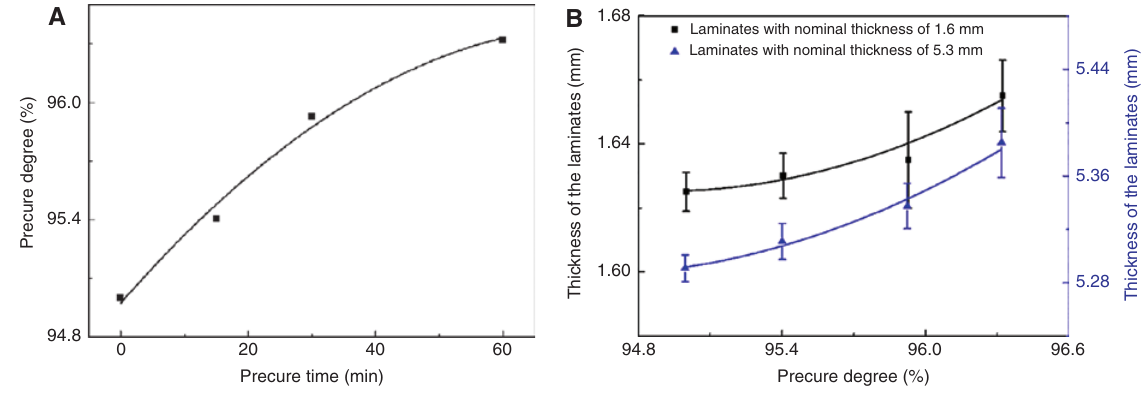
Figure 3: Precure degree of carbon/benzoxazine prepregs plotted with (A) precure time at 80 ° C, (B) measured thickness of composite laminates.